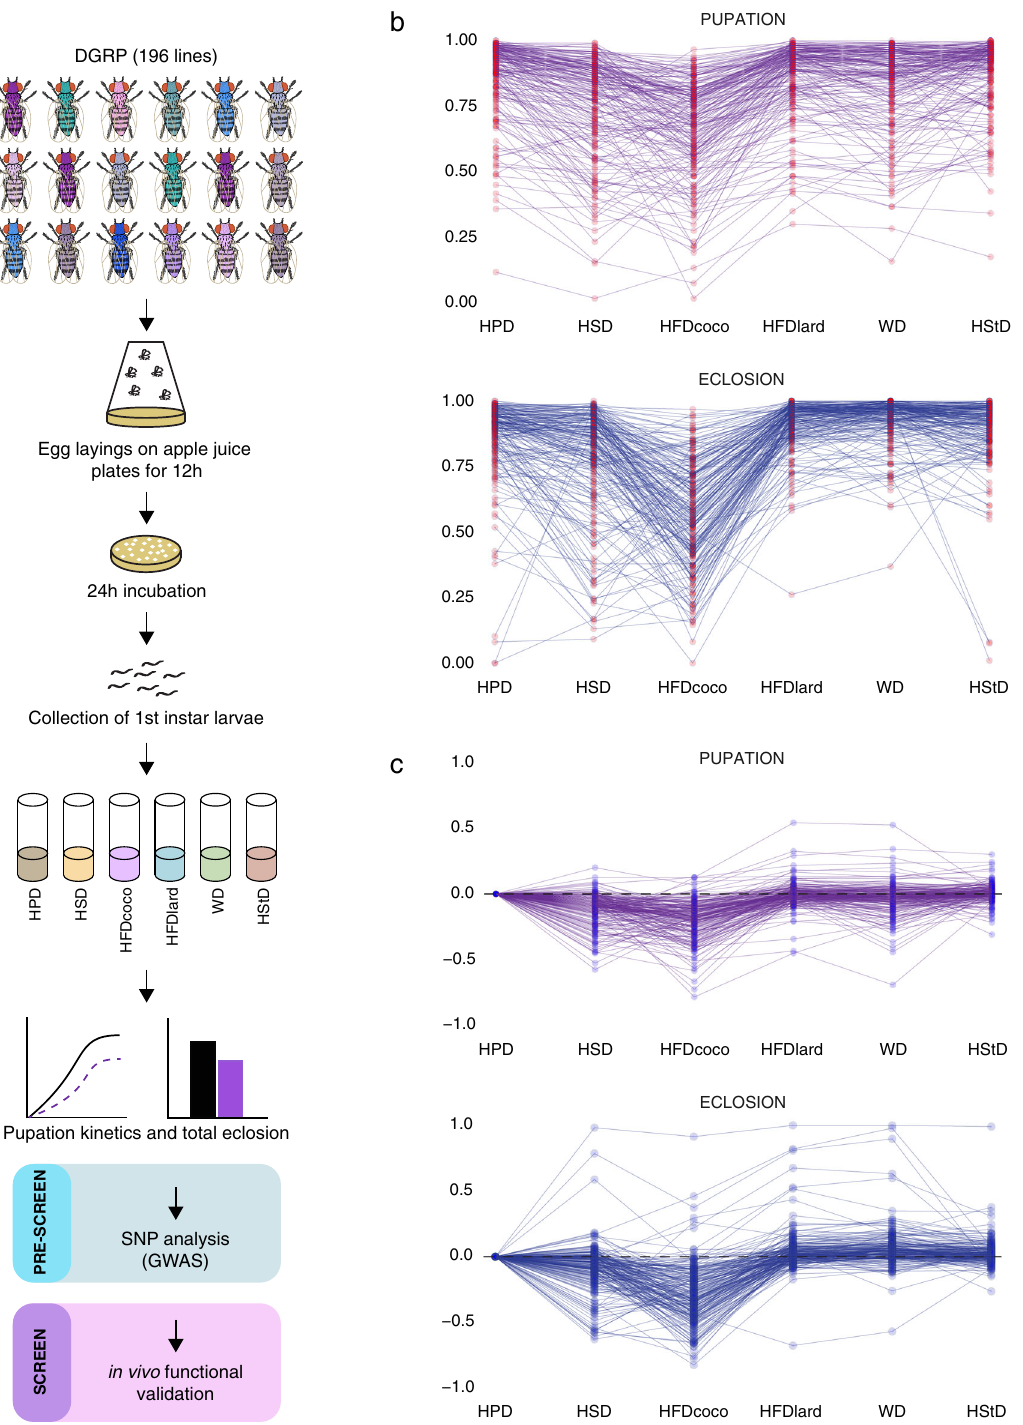
Fig. 1 Experimental outline and survival of DGRP across the six diets. a The experimental outline. 196 lines of the Drosophila melanogaster genetic reference panel (DGRP) were raised on six different diets: high-protein (HPD), high-sugar (HSD), high-fat-coconut-oil (HFDcoco), high-fat-lard (HFDlard), Western (WD), and high-starch (HStD). First-instar larvae were collected onto the diets in a controlled density of 30 larvae per vial, and at four replicate vials per diet. The experiment was run in cohorts of 10 strains (all diets at the same time). Pupation was monitored daily to establish pupation kinetics of each strain across the diets and fi nally total eclosion was scored two weeks after. HPD was composed of 10% (w/v) dry baker ’ s yeast, and the other diets had the same amount of yeast as a base. HSD was supplemented with 20% (w/v) sucrose, HFDcoco with 20% (w/v) coconut oil, HFDlard with 20% (w/v) lard, WD with 10% (w/v) sucrose and 10% (w/v) lard, and HStD with 20% (w/v) potato starch. b Survival of the 196 DGRP strains to pupal stage (pupation) and to adult (eclosion) across the six diets. Pupation rate standard deviations (among lines) of 0.194 (HSD), 0.188 (HFDcoco), 0.162 (WD), 0.145 (HPD), 0.144 (HFDlard), and 0.140 (HStD). Eclosion rate standard deviations (among lines) of 0.211 (HSD), 0.203 (HFDcoco), 0.166 (HPD), 0.138 (HStD), 0.099 (HFDlard), and 0.092 (WD). c HPD-normalized survival of the 196 DGRP strains to pupal stage (pupation) and to adult (eclosion) across the other fi ve diets. Source data are provided as a Source Data fi